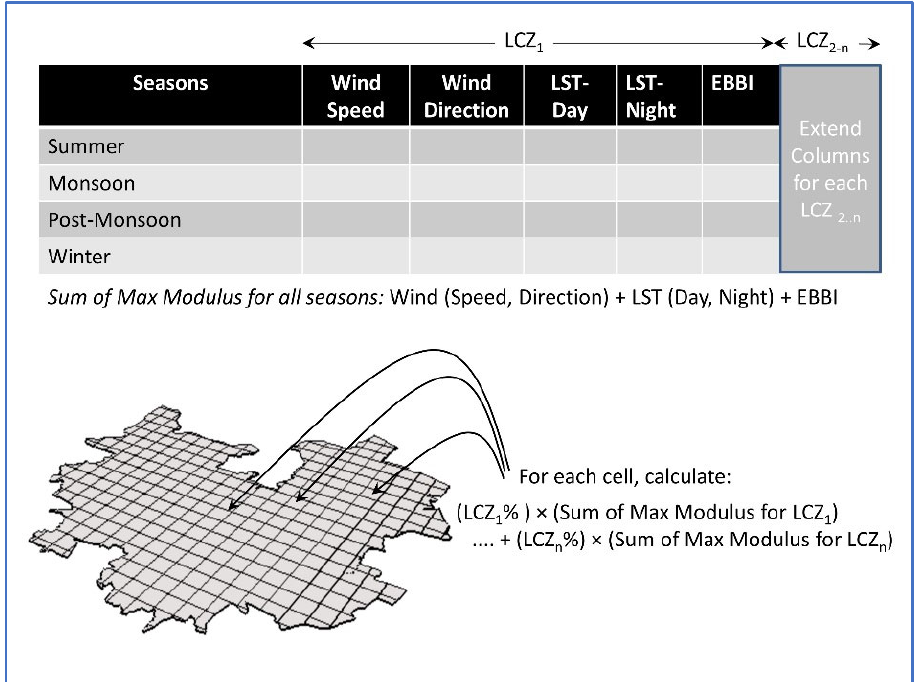
Figure 3. Ranking grids based on seasonal and annual variation (Step 2).